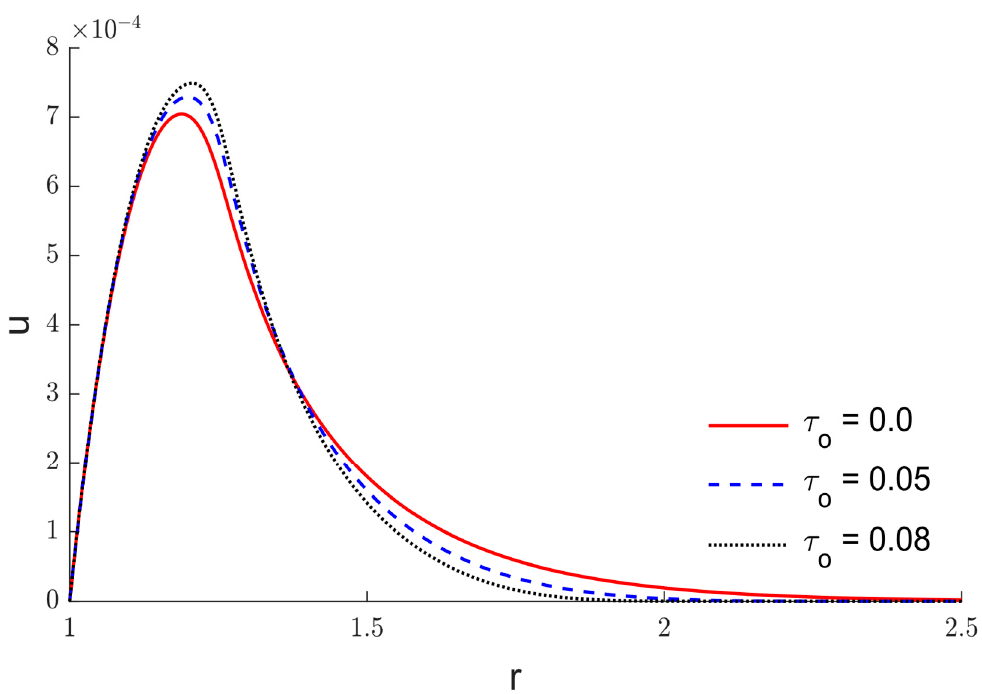
Figure 7. The impacts of thermal relaxation time τ o in the variation of radial displacement u when K n = −0.6 .